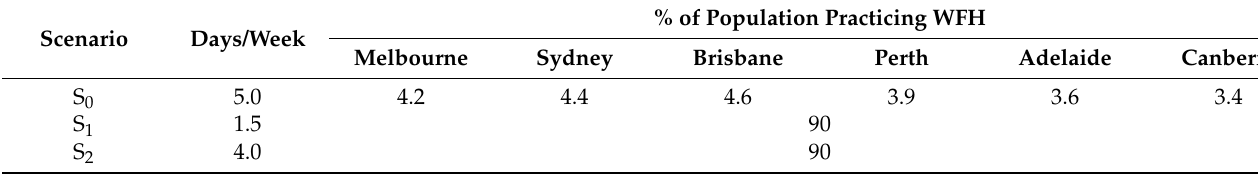
Table 1. WFH scenarios used in this